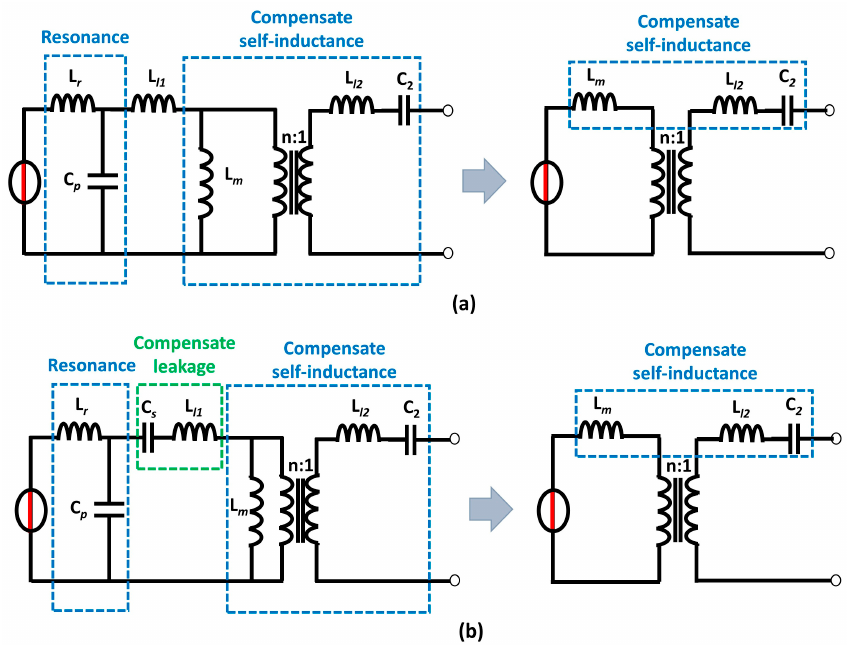
Figure 19. Multi-element T-type compensation scheme: ( a ) LCL (constant voltage source); and ( b ) LCC (constant voltage source) [16].